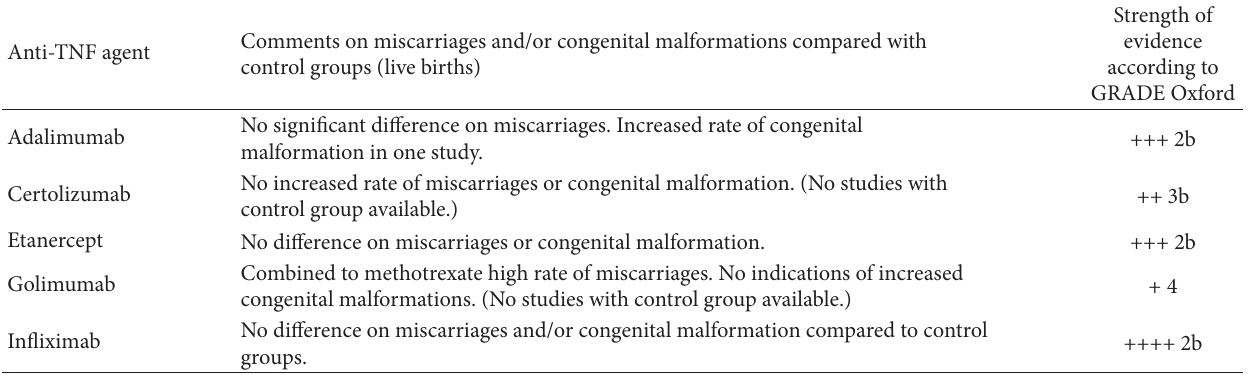
Table 2: Summary of studies and results of pregnancy exposure related to anti-TNF agents used to treat rheumatic diseases, SLR-period 2008–2015